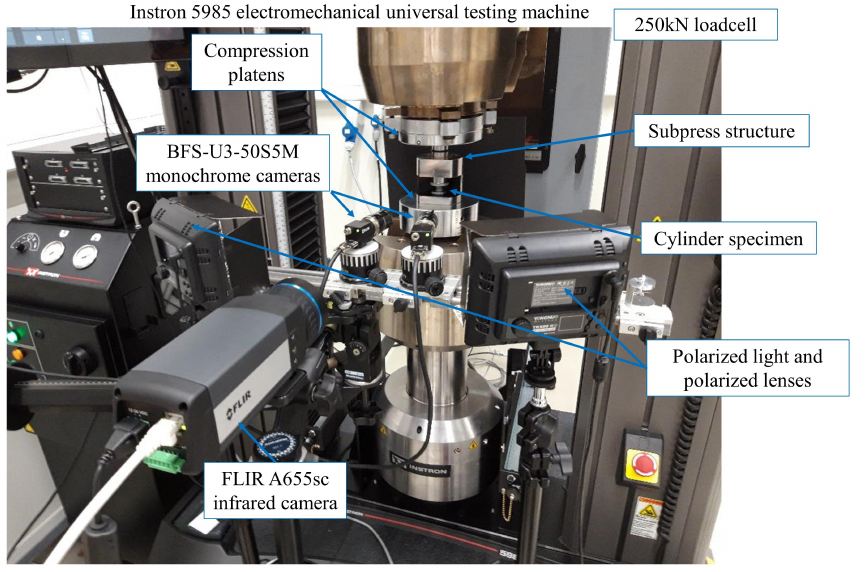
Figure 3. Subpress fixture mounted in Instron 5985 electromechanical test bench that equips DIC and temperature measuring